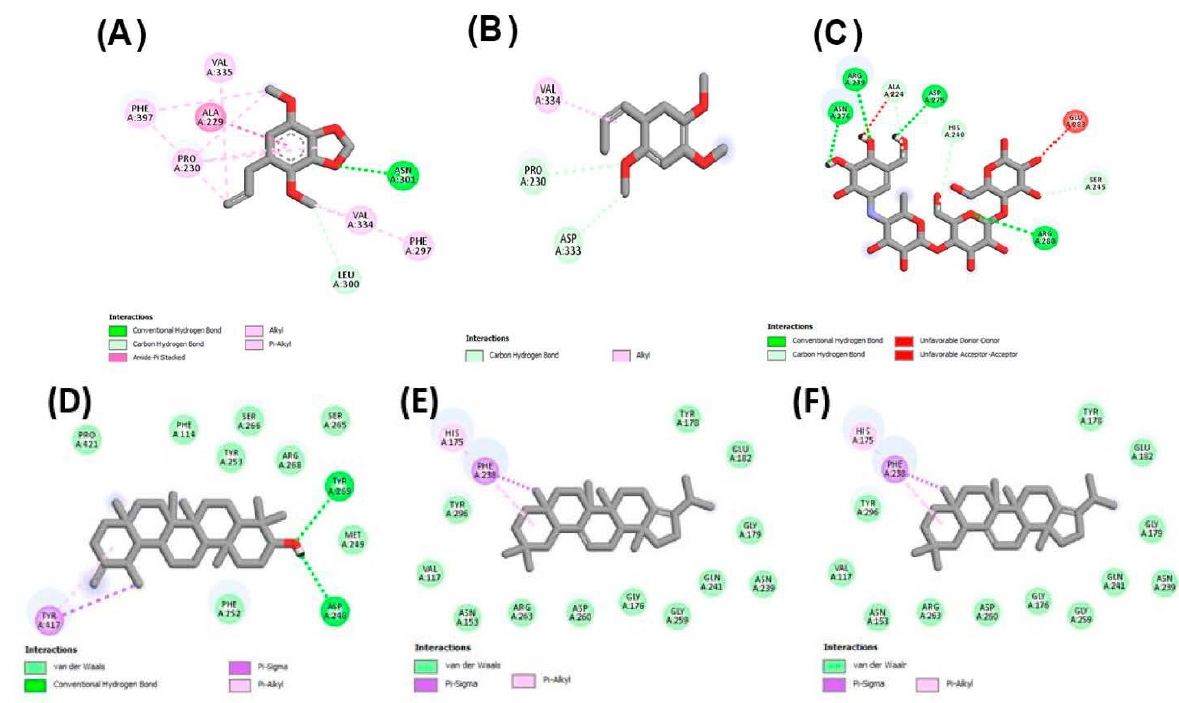
Figure 5. Interactions of residues of α -amylase active site (2D presentation) with ( A ) apiol, ( B ) octa- decadienoic acid, ( C ) acarbose, ( D ) a-neooleana-3(5), 12-dien, ( E ) lanosterol, ( F ) 3-epimoretenol.